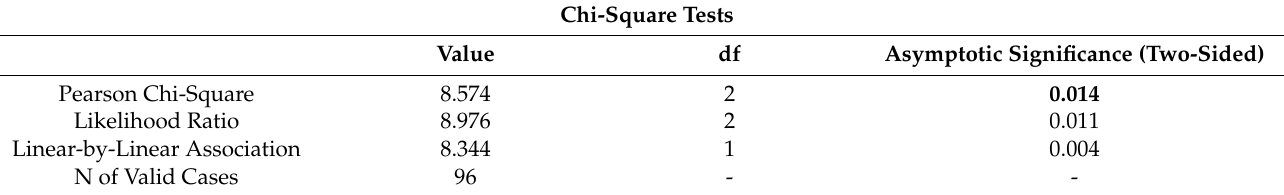
Table 5. Results of Chi-square test for variables role and first main advantage